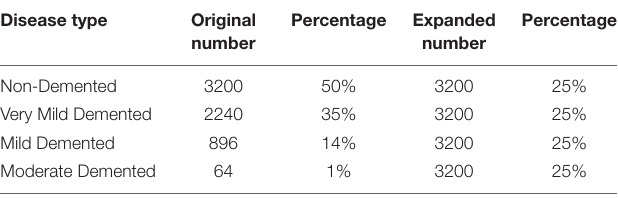
TABLE 5 | The influence of attention mechanisms on network accuracy.